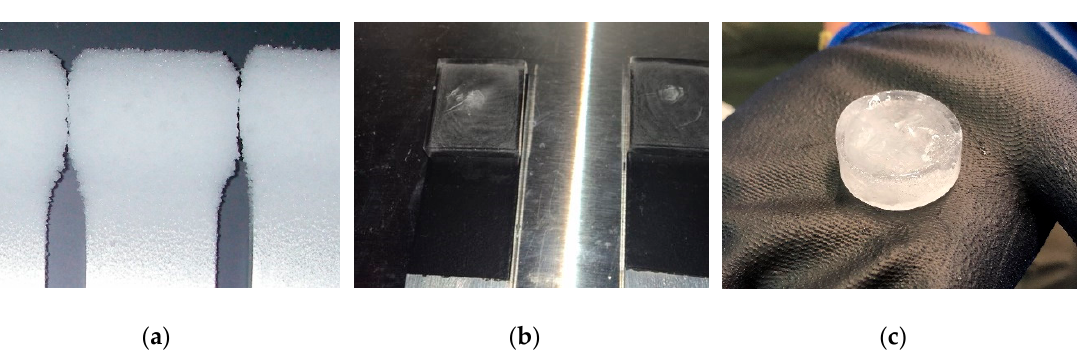
Figure 1. Pictures of the ice types tested in the study. ( a ) Illustration of precipitation ice (PI) created at the Anti-icing International Materials Laboratory (AMIL) (Tair = − 18 °C); ( b ) illustration of bulk water ice (BWI) created at AMIL (Tair = − 18 °C); ( c ) illustration of bulk water ice created at the Nanomechanical Lab at the Norwegian University of Science and Technology (NTNU) (Tair = − 18 °C).